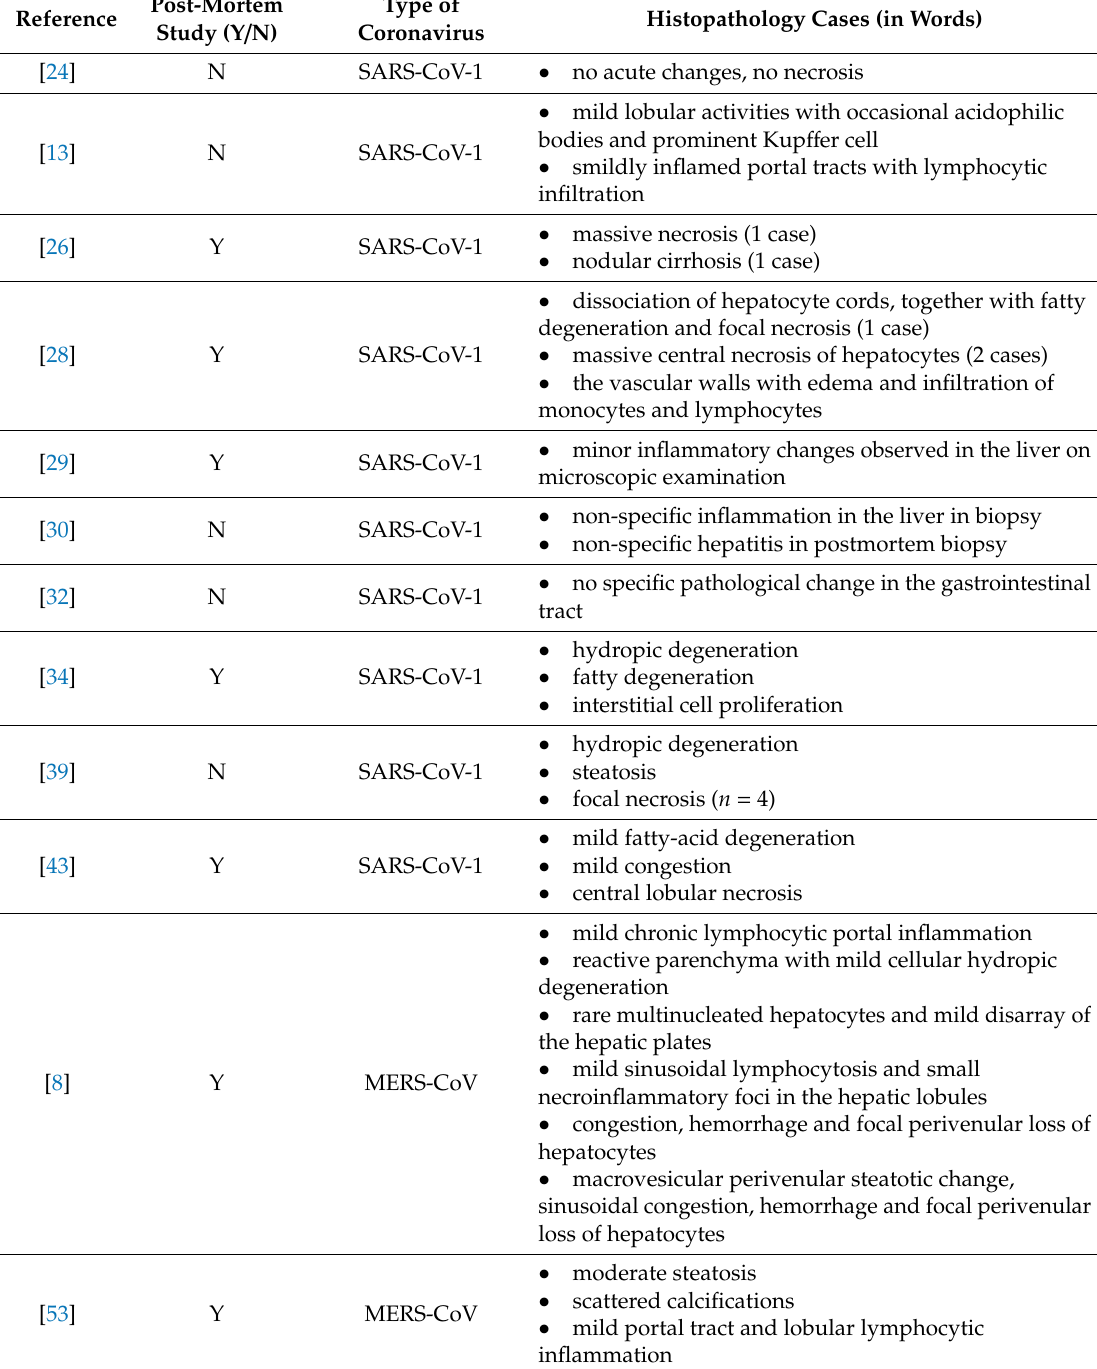
Table 3. Histopathological findings within the livers of patients infected with